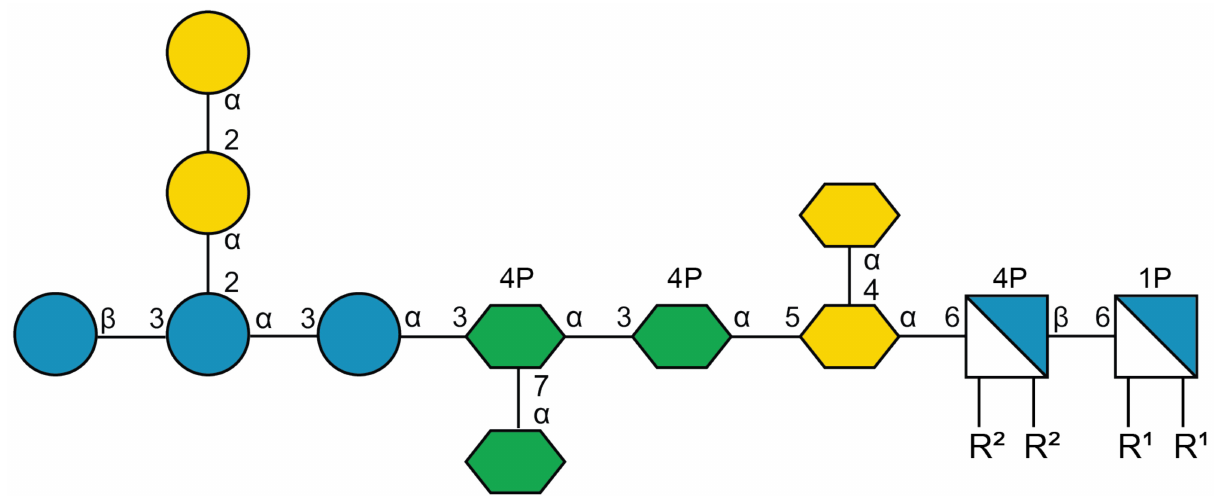
Figure 1. Structural representation of outer (to the left) and inner (middle section) portions of the R1 core and the lipid A (to the right) of LPS [20]. R 1 and R 2 represent acyl groups attached to glucosamine residues of Lipid A. The structure is reported utilizing the Symbol Nomenclature For Glycans (SFNG) representation